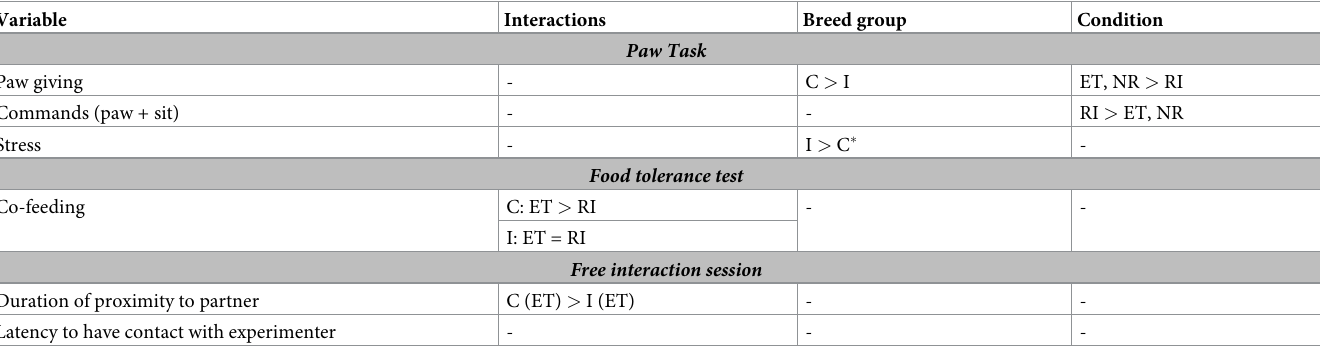
Table 3. Summary of